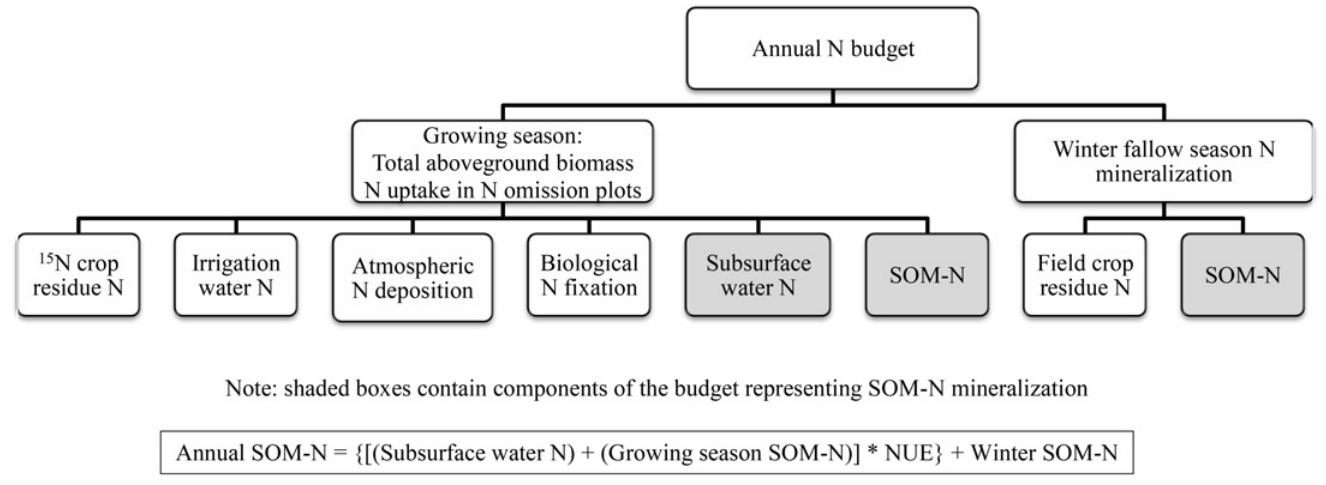
Fig 1. Conceptual model of the annual (growing and winter fallow season) N budget. The growing season portion is based on aboveground biomass N uptake in 0N plots and N uptake contributions from crop residue, water, SOM sources, atmospheric N deposition, and biological N fixation. The winter fallow season N budget is comprised of crop residue and SOM mineralization. All components of the model were determined experimentally except the values for atmospheric N deposition and biological N fixation which were estimated from available literature.